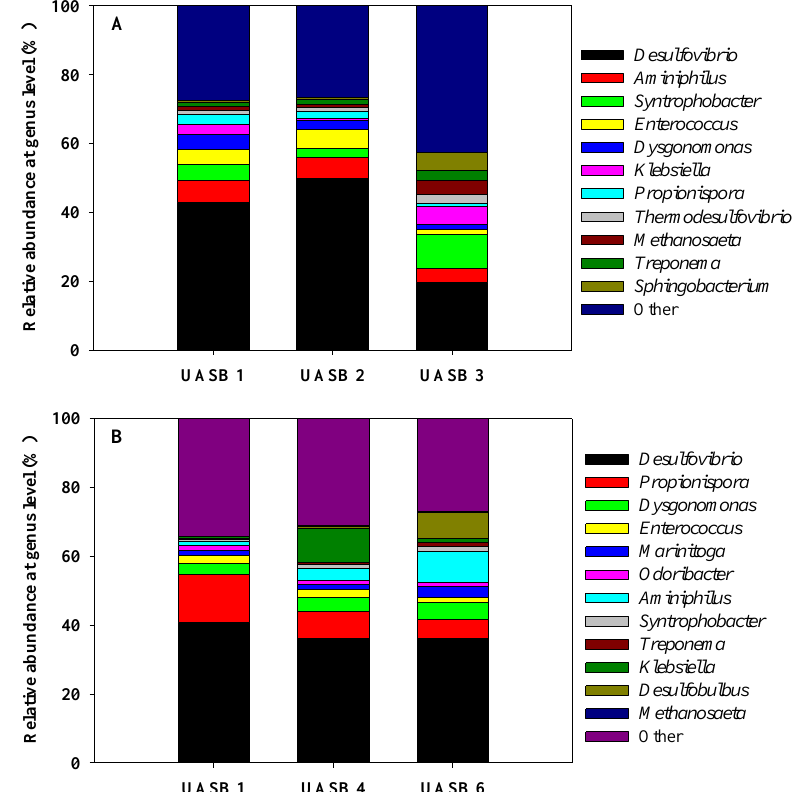
Figure 5. Microbial diversity along the sludge bed heights at the genus level. ( A ) Samples were collected on day 173 of the reactor operation. ( B ) Samples were collected on day 230 of the reactor operation.